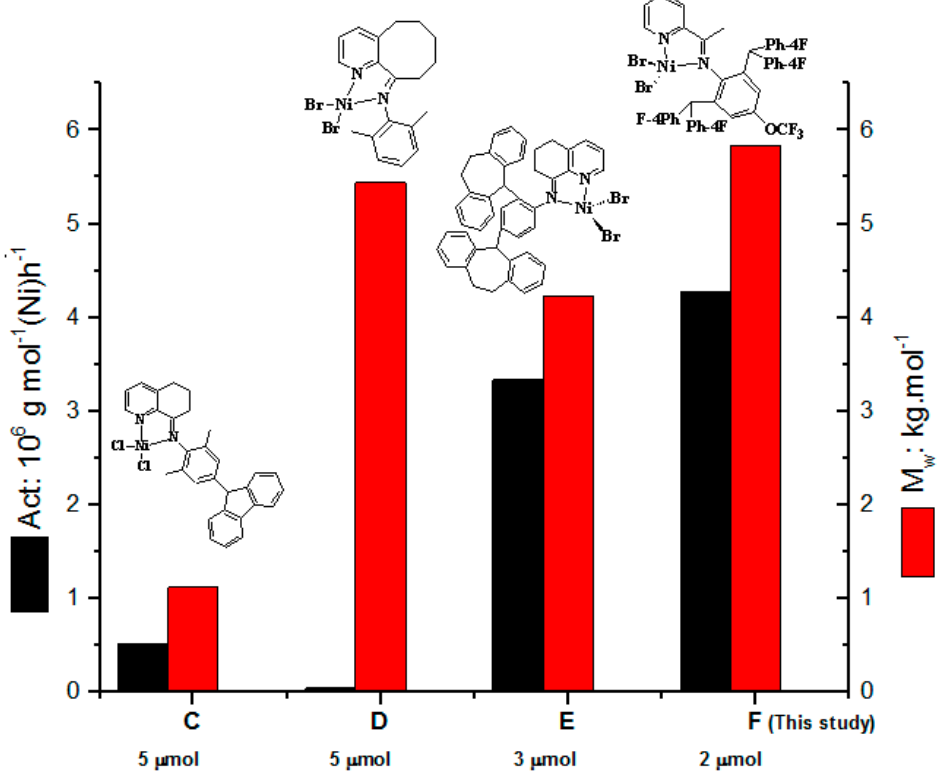
Figure 10. Comparison of F with previously reported non-fluorinated C , D and E under optimal conditions at 10 atm of C 2 H 4 .